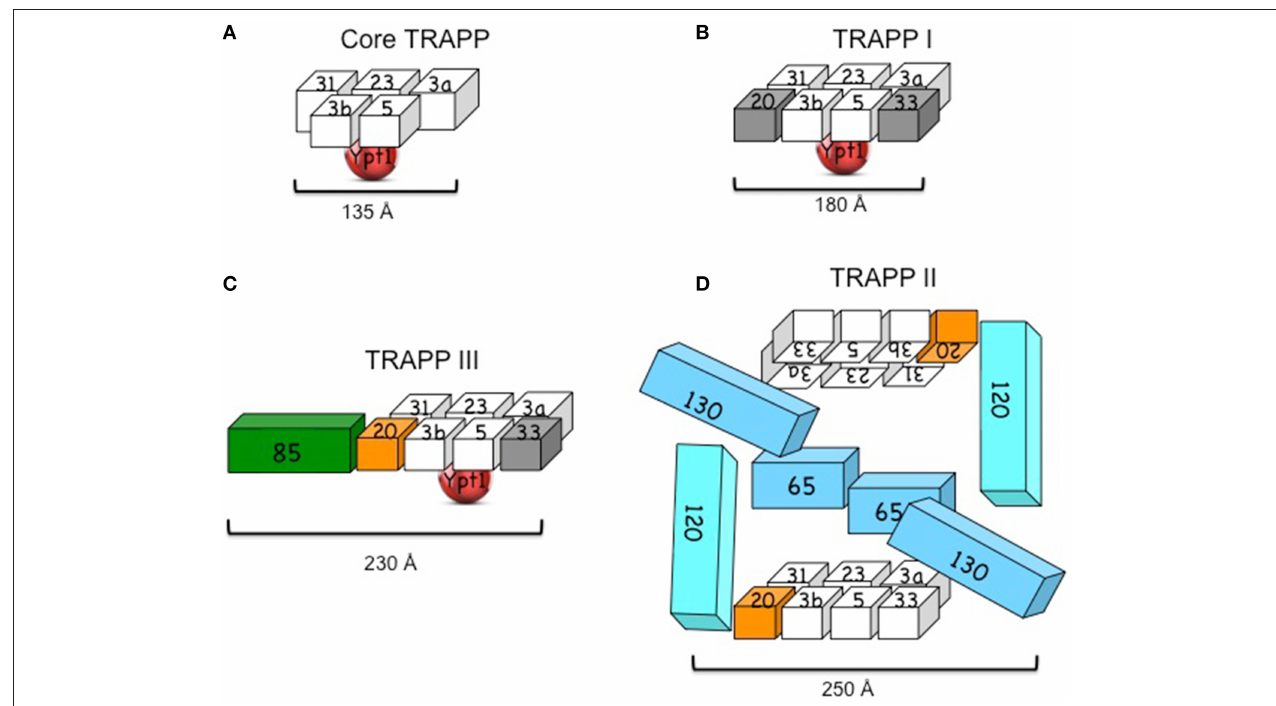
FIGURE 1 | Yeast TRAPP complexes. (A) Core TRAPP, which contains four small subunits with two copies of Bet3 (3a and 3b), self assembles, binds Ypt1 through Bet5 and Trs23 and acts as a Ypt1-GEF. The diagram is based on the published structure of core TRAPP in a complex with Ypt1 (Cai et al., 2008). (B) TRAPP I contains core TRAPP, Trs20 and Trs33. However, it is not clear that the presence of the latter two subunits (in gray) is required for its function. The diagram is based on the published EM structure of core TRAPP subunits with Trs33 or Trs20 (Kim et al., 2006). (C) TRAPP III contains core TRAPP, Trs20 (orange), which is required for its assembly with Trs85 (green) and its function in autophagy. A role for Trs33 (in gray) in this complex has not been shown. The diagram is based on the published architecture and mutational analysis of TRAPP III ( Tan et al., 2013; Taussig et al., 2014). (D) TRAPP II contains TRAPP I, including Trs20 (orange) and Trs33, and three large subunits: Trs120, Trs130, and the non-essential Trs65. Trs20 is required for the interaction of TRAPP I with Trs120, and either Trs65 or Trs33 are required for assembly of TRAPP II in vivo . TRAPP II is depicted here as a dimer (see discussion in the text). The cubes representing the subunits are roughly proportionate to their size; numbers stand for TrsN, except for Bet3 and Bet5. Approximate length (Å) is based on crystal structure for core TRAPP and negative staining EM for the other complexes (see